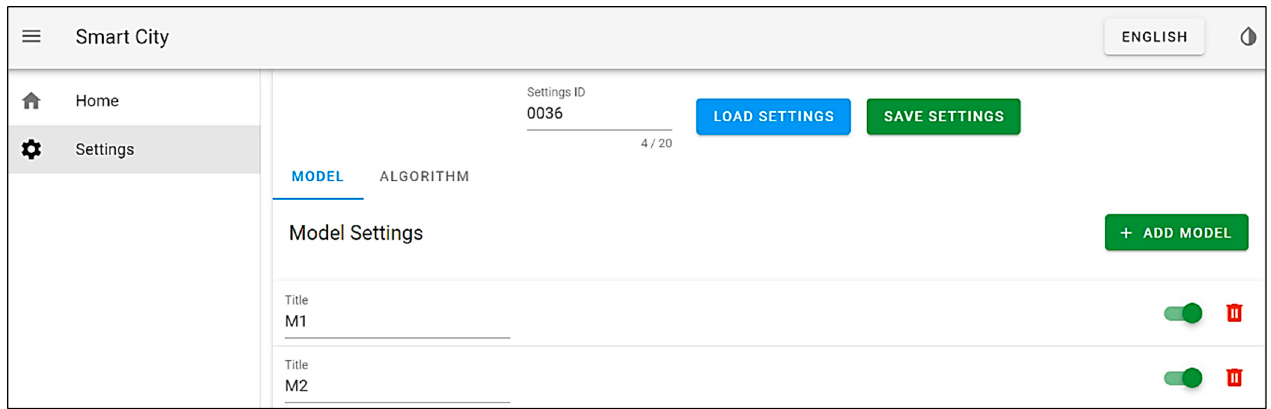
Figure 8. ID for the evaluation information model members of the Transport and Construction Commission.